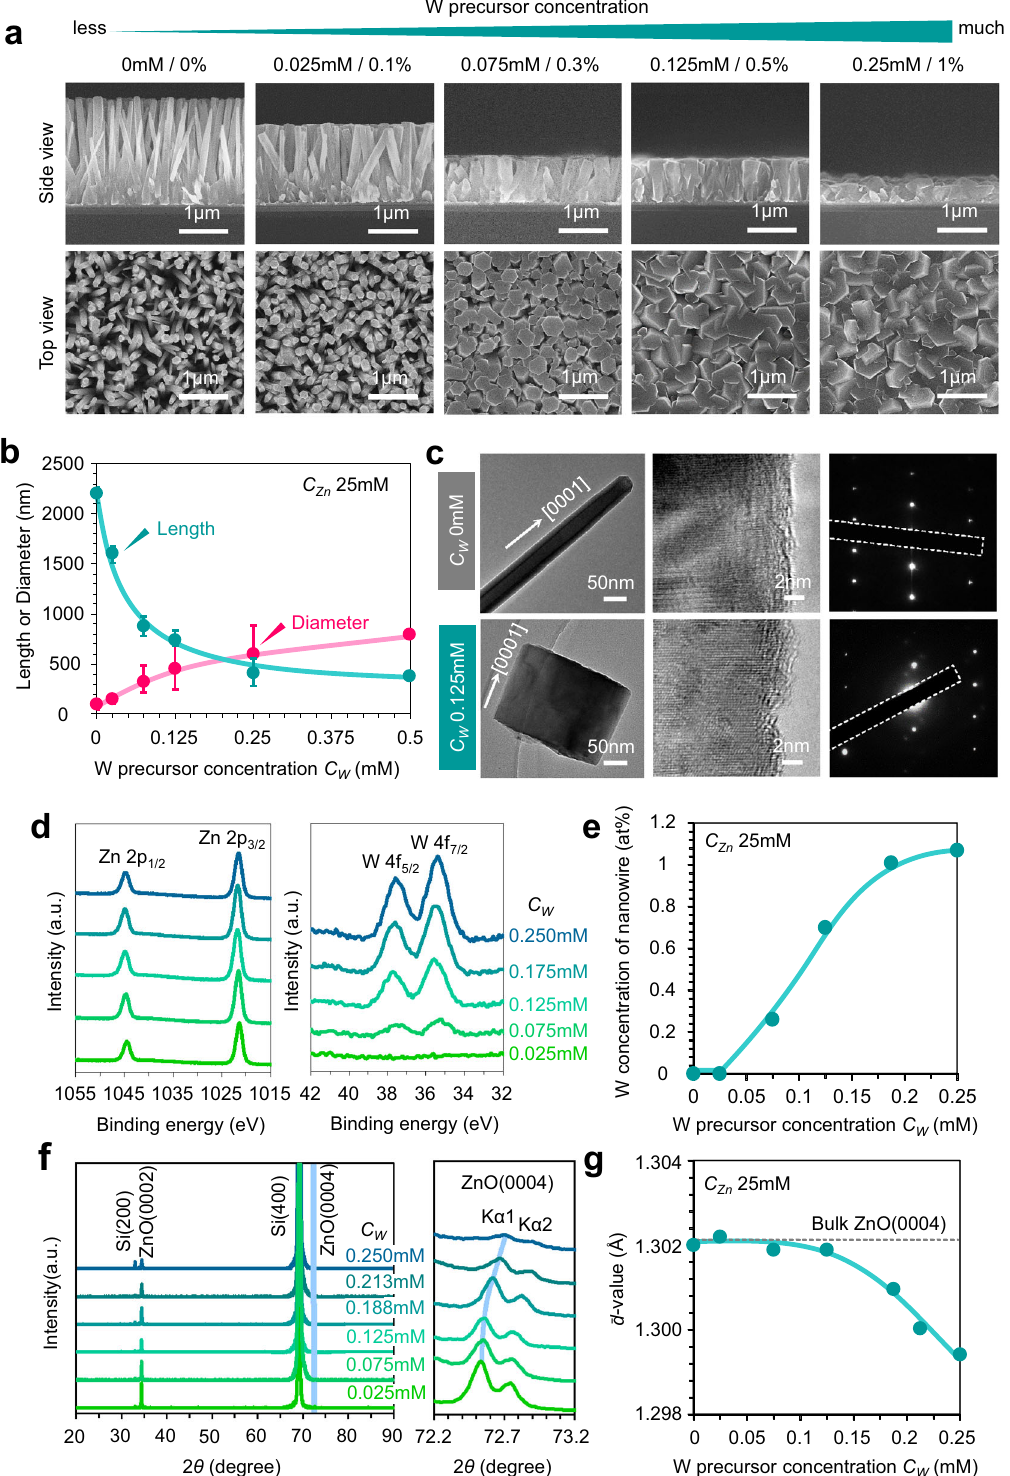
Fig. 1 Morphology, composition, and crystal structure of nanowires with varying C W . a SEM images and b statistic length and diameter data of ZnO nanowires grown with varying C W . C Zn is kept to be 25 mM. The error bars are de fi ned by standard deviation values. c TEM images and selected area electron diffraction (SAED) patterns of both nanowire and nanoplatelet grown with C W 0 mM and C W 0.125 mM, respectively. d Zn 2 p and W 4 f XPS spectra and e W concentration of ZnO nanowires grown with various C W . f XRD patterns and g d value of ZnO nanowires grown with various C W